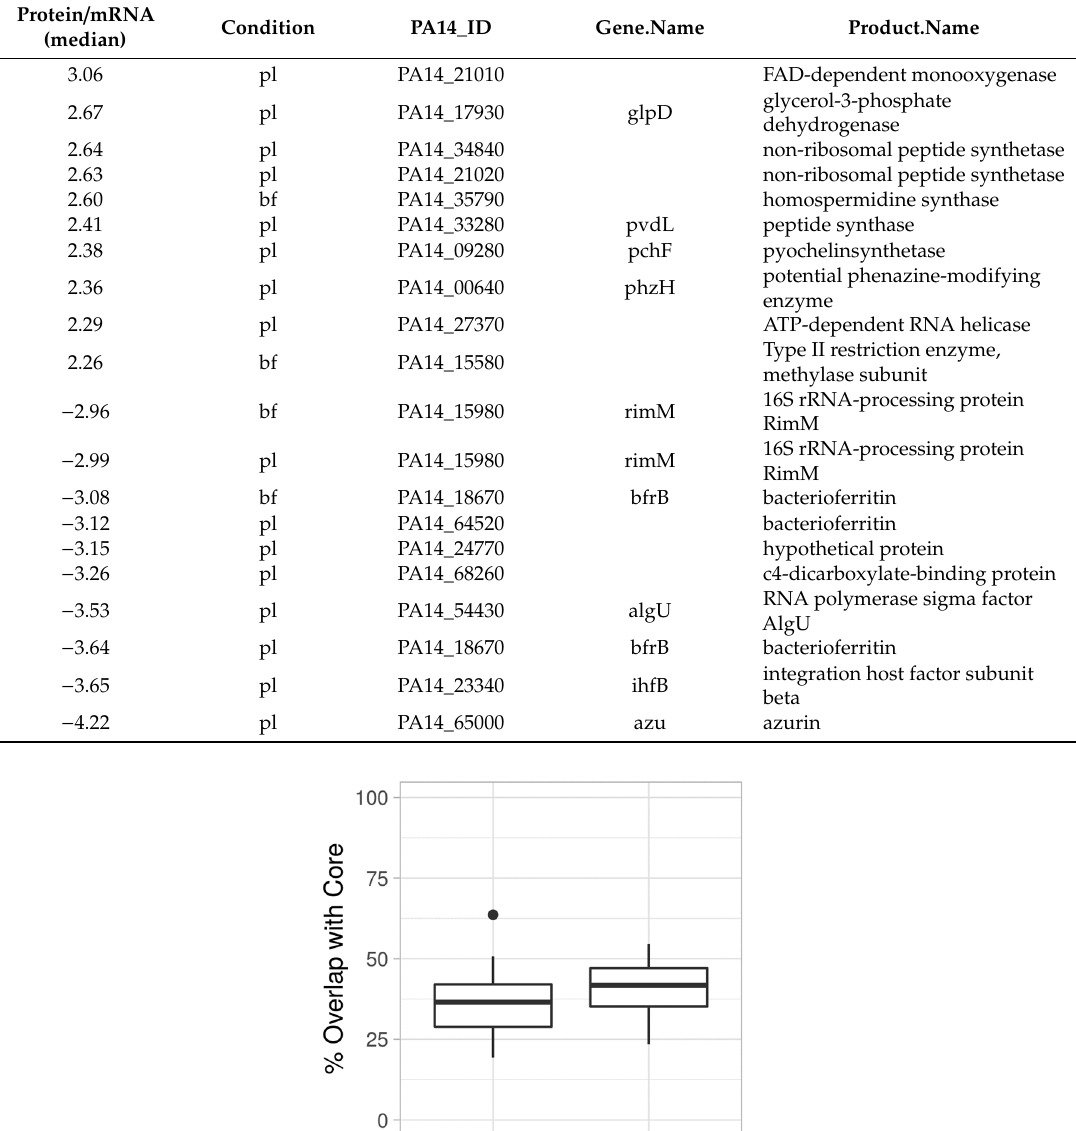
Table A1. Genes with the highest and lowest protein-to-mRNA ratio.The median of the 10 highest and lowest protein-to-mRNA ratio (log2) throughout all strains under the given condition.